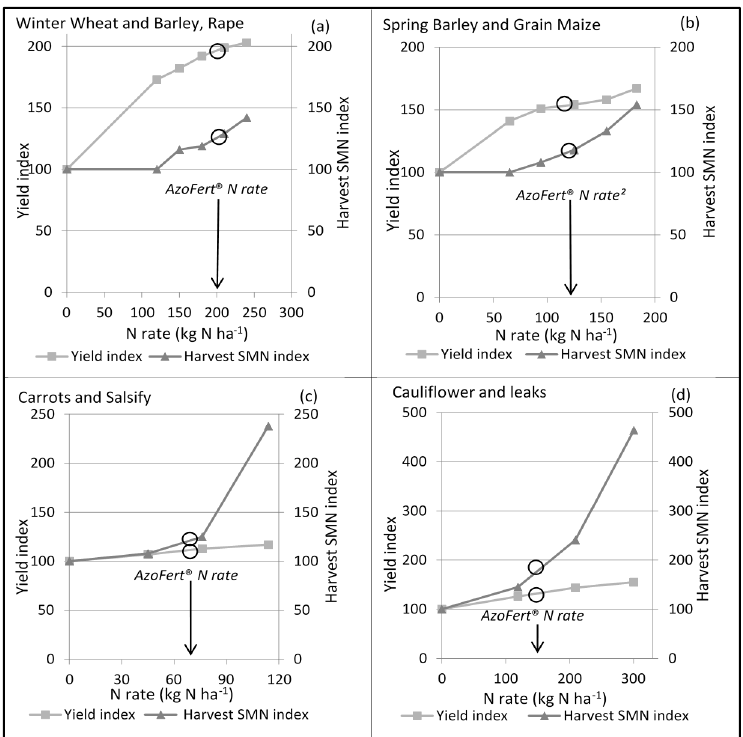
Figure 5. Relative changes in yield and soil mineral N at harvest time as a function of the fertiliser N dose. ( a ) winter crops; ( b ) spring crops; ( c , d ) field vegetables. The data are the mean of 23 field